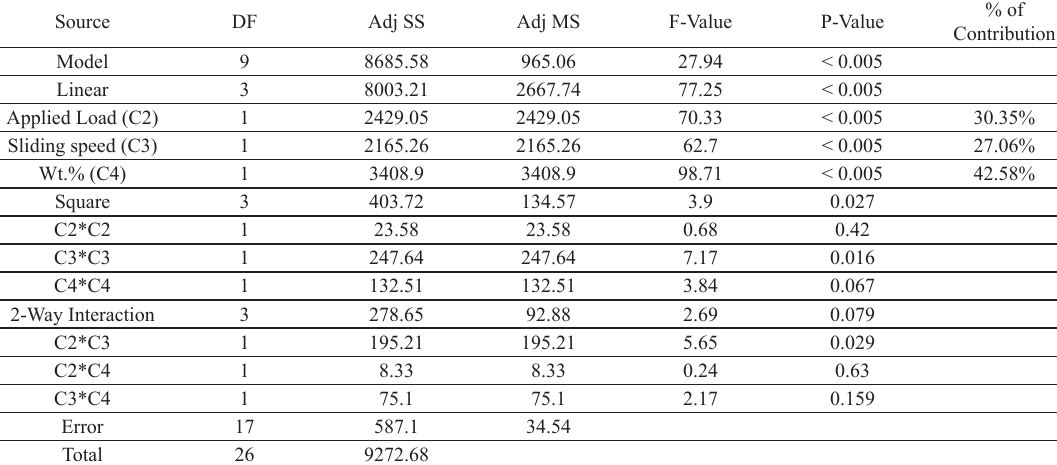
Table 3. Factor contribution of wear.